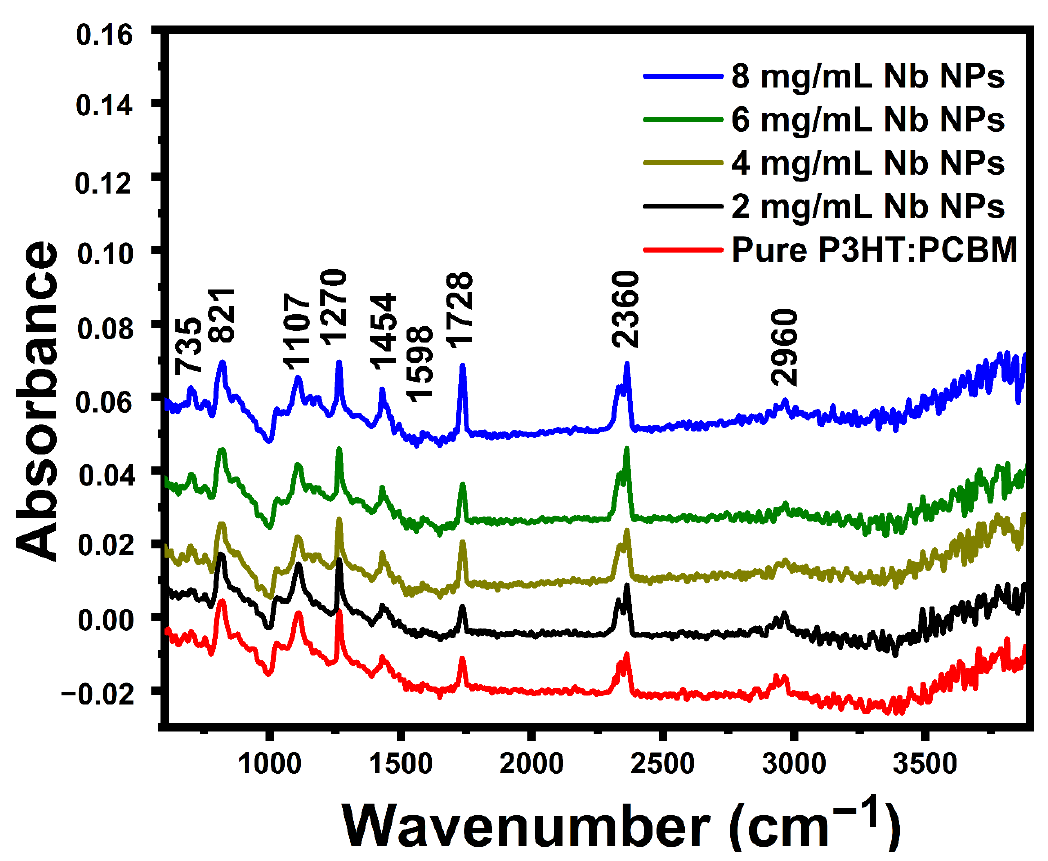
Figure 4. FT-IR spectra of pure P3HT:PCBM and P3HT:PCBM:Nb blends synthesized with various Nb nanoparticle doping concentrations.